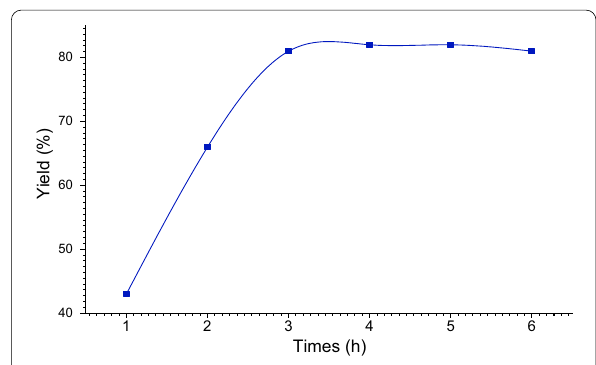
Fig. 8 Influence of the reaction time on the yield